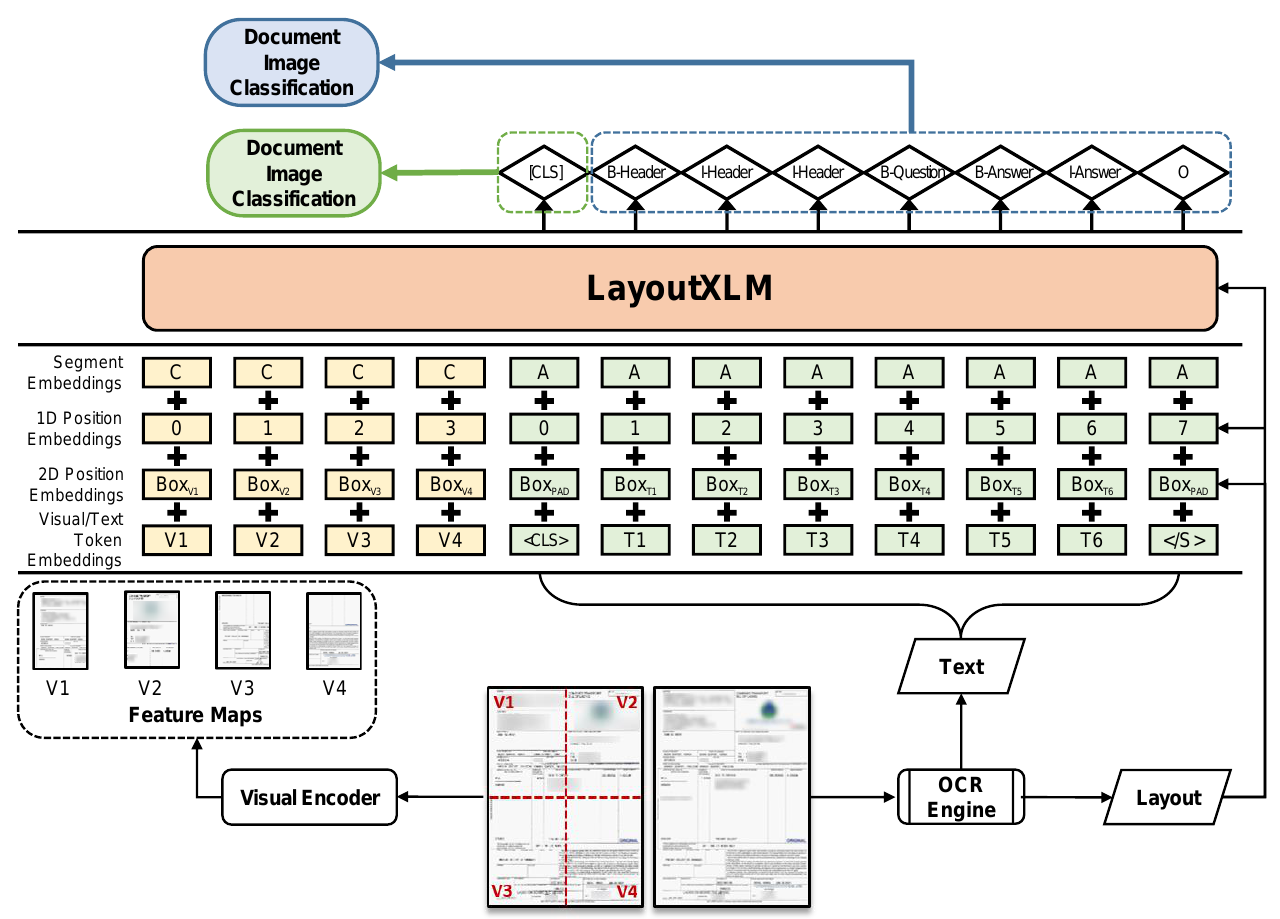
Figure 4. Structure of the unstructured document image understanding model (LayoutXLM).